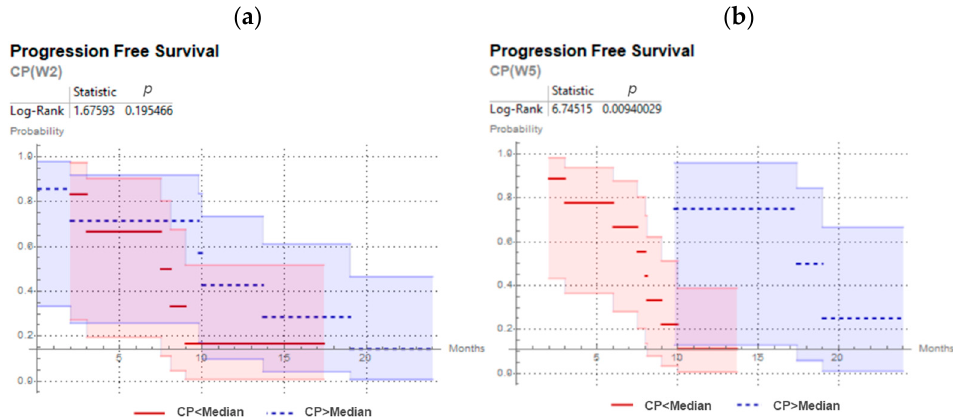
Figure 6. Kaplan–Meier curves and log-rank test for CP predicting progression free survival for head and neck cancer patients of the validation cohort, with 18 F-FMISO PET/CT at second week ( a ) and at fifth week ( b ) of chemoradiotherapy.